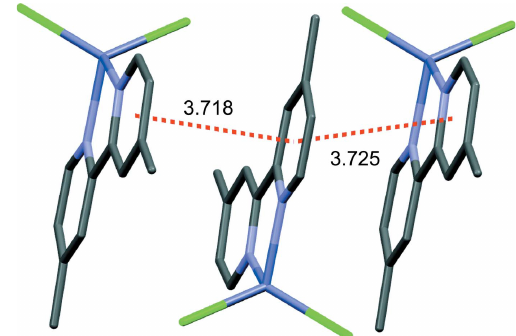
Figure 3 Capped sticks representation of the title molecule showing (cid:2) – (cid:2) stacking interactions (red). H atoms and acetonitrile molecule are omitted for clarity.